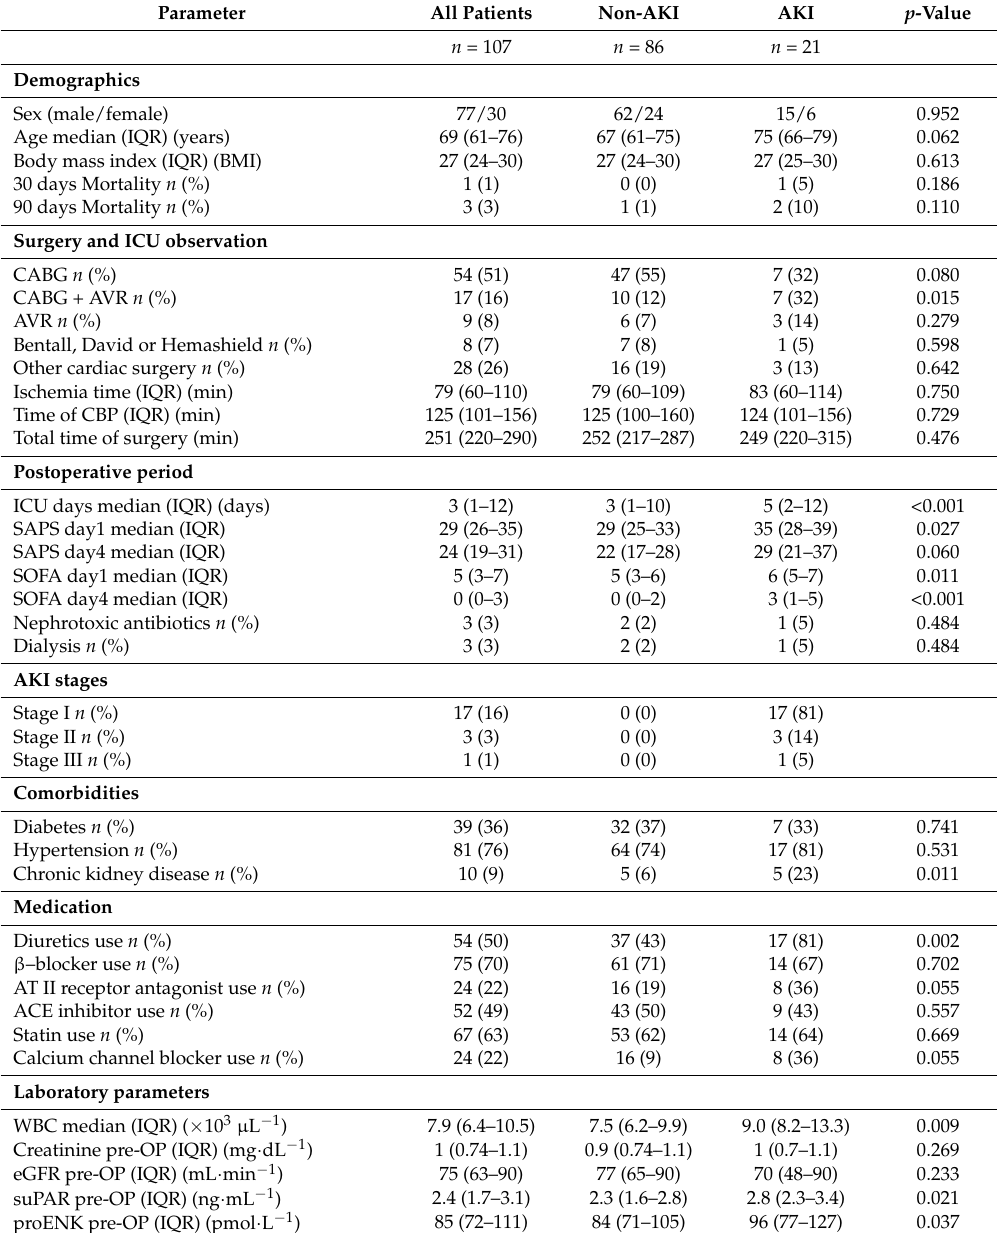
Table 1. Baseline patient